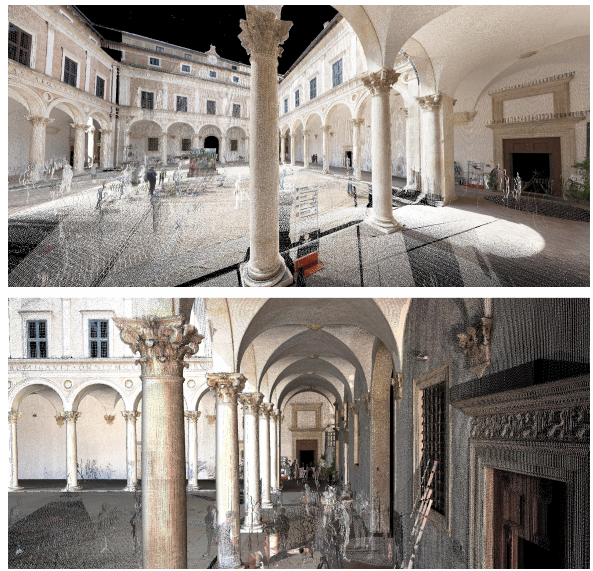
Table 1. Number of points, max/min alignment error and RMS of the two TLS point clouds considered in this study.